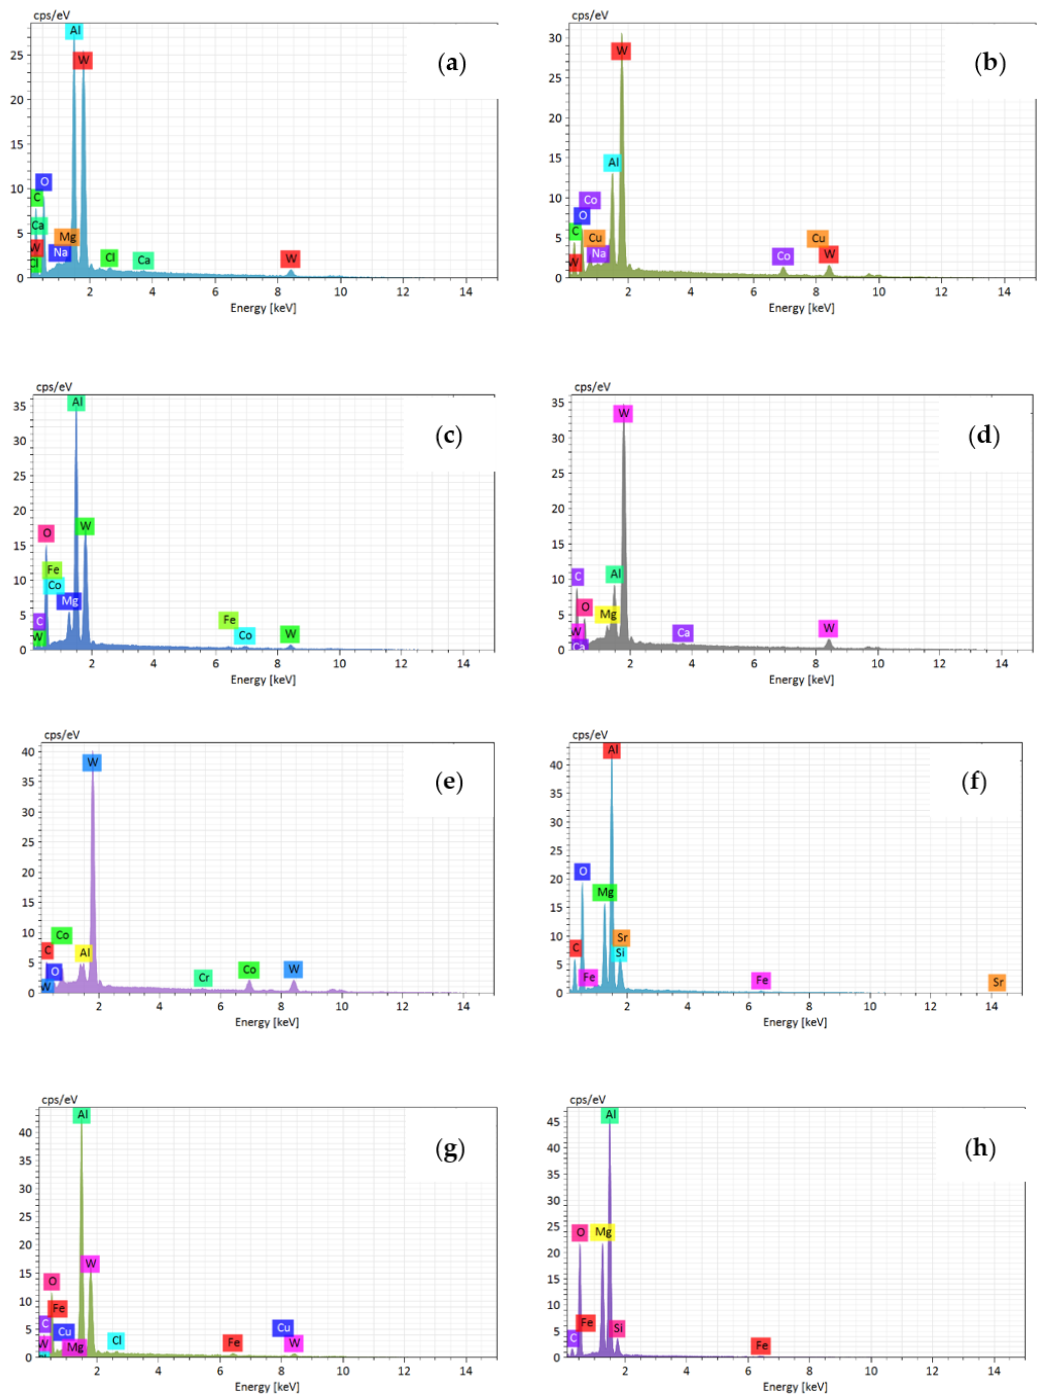
Figure 5. The energy disperse spectroscopy results of rake face at different cutting speed (( a – h ) represent the points A~H in the Figure 4 respectively).